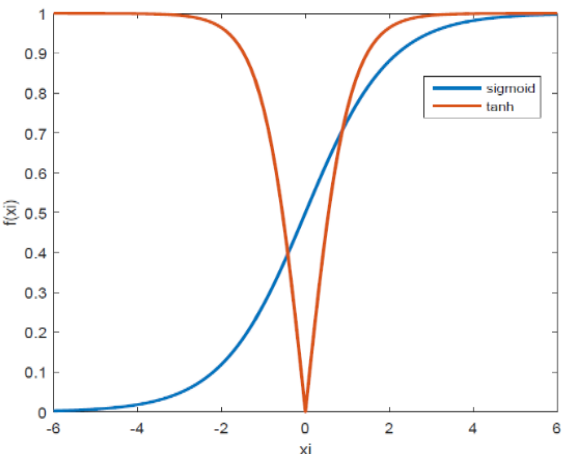
Figure 3. Mapping functions of values.